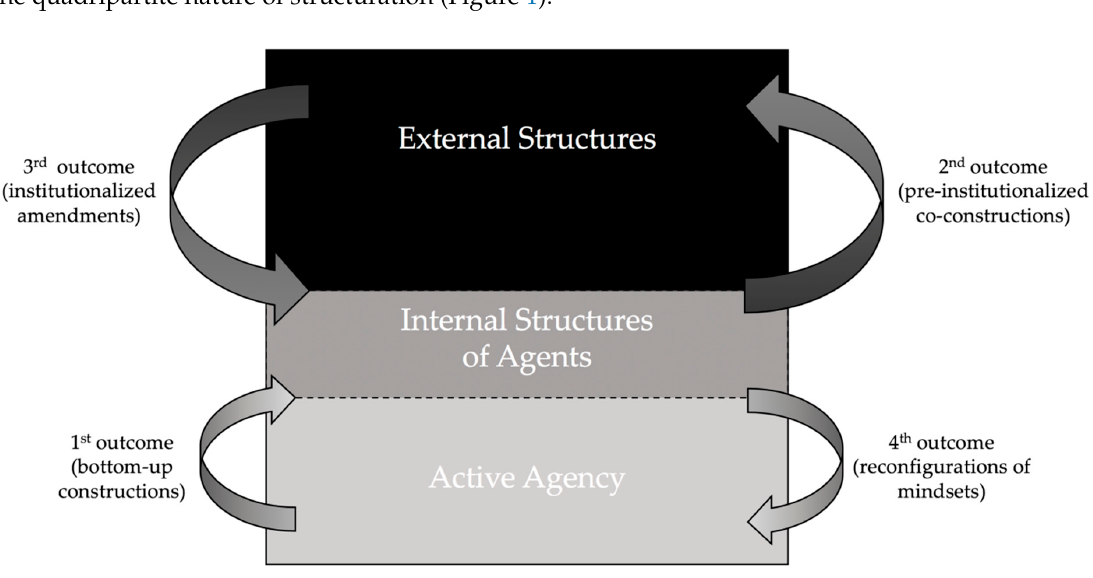
Figure 1. Quadripartite nature of structuration. Source: Authors’ work.